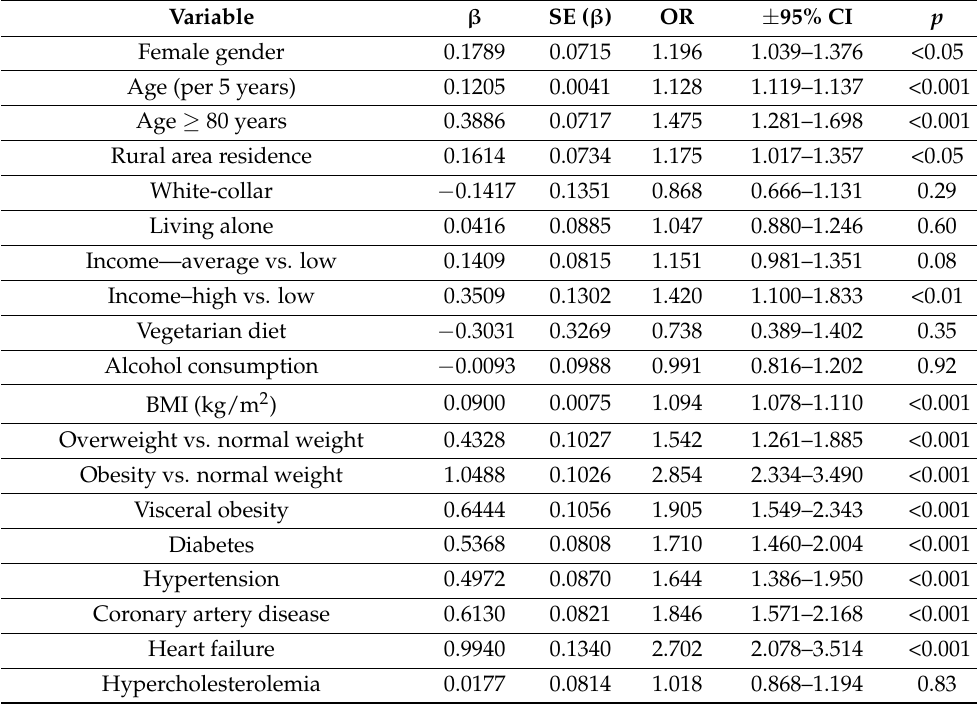
Table 2. Risk factors of hyperuricemia in univariable logistic regression.